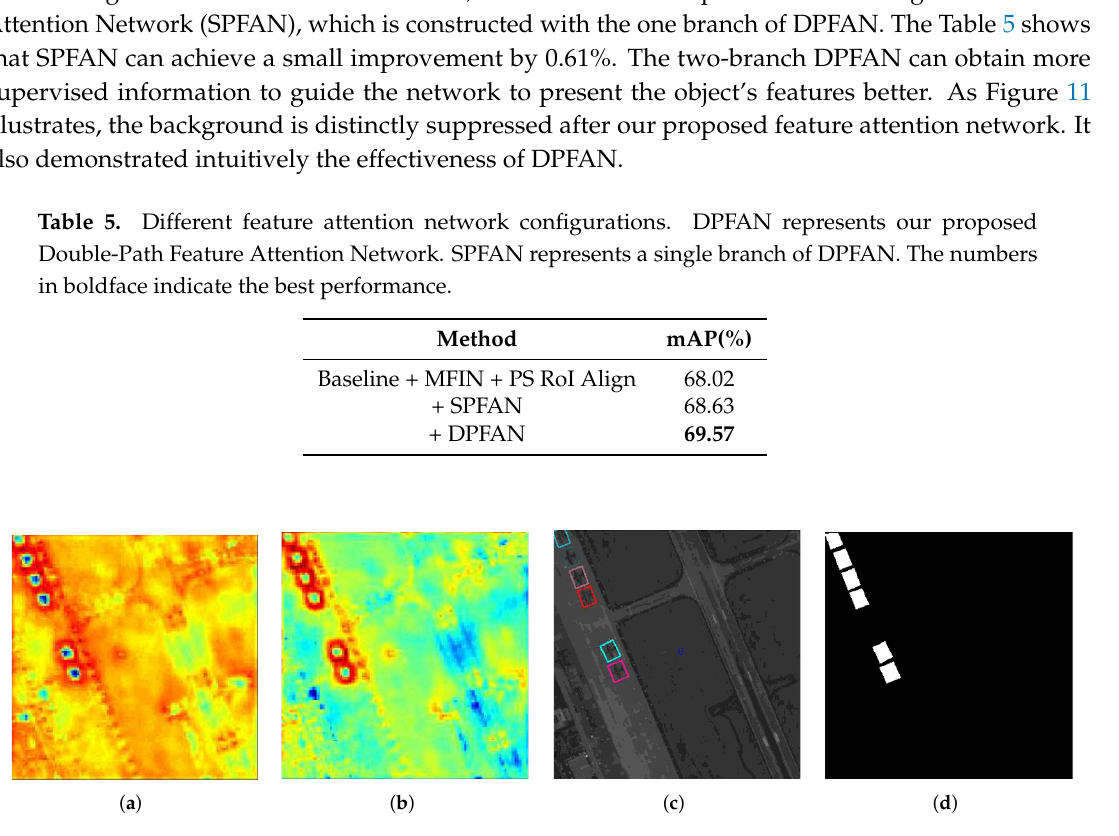
Figure 11. Visualization of the attention network of DPFAN. ( a ) Input feature map of DPFAN; ( b ) Output feature map of DPFAN; ( c ) Ground truth; ( d ) Binary mask map as supervised information for attention